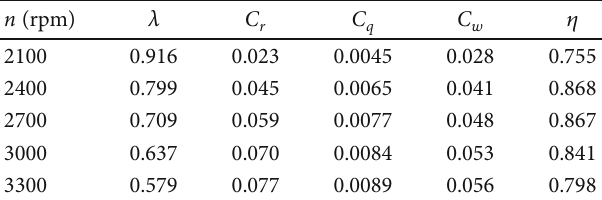
Figure 14: Propeller in the wind tunnel. Table 5: Propeller performance data (wind speed